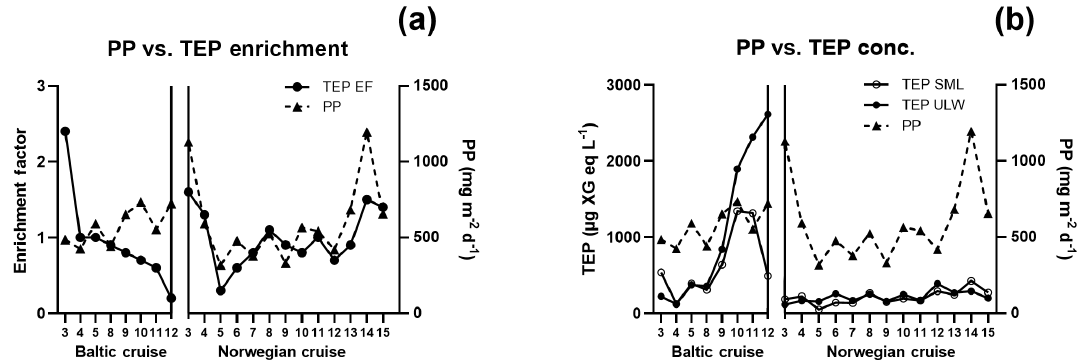
Figure 3. Comparison of (a) TEP enrichment and (b) concentration with primary production (PP) along the cruise tracks for the Baltic and Norwegian cruises; numbers on the x axis denote station